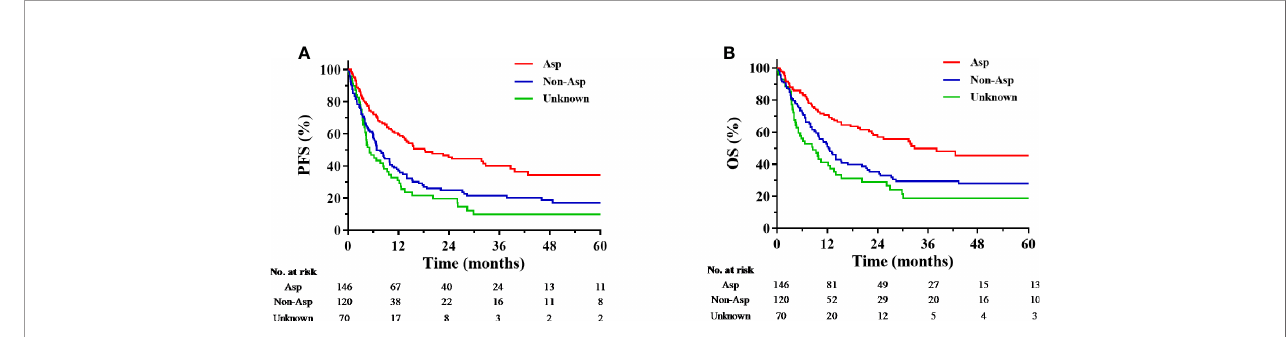
FIGURE 2 | Kaplan-Meier progression-free survival (A) and overall survival (B) curves for the subgroups receiving chemotherapy with different regimens. Asp, asparaginase-containing regimens; Non-Asp, non-asparaginase-containing regimens; OS, overall survival; PFS, progression-free survival.